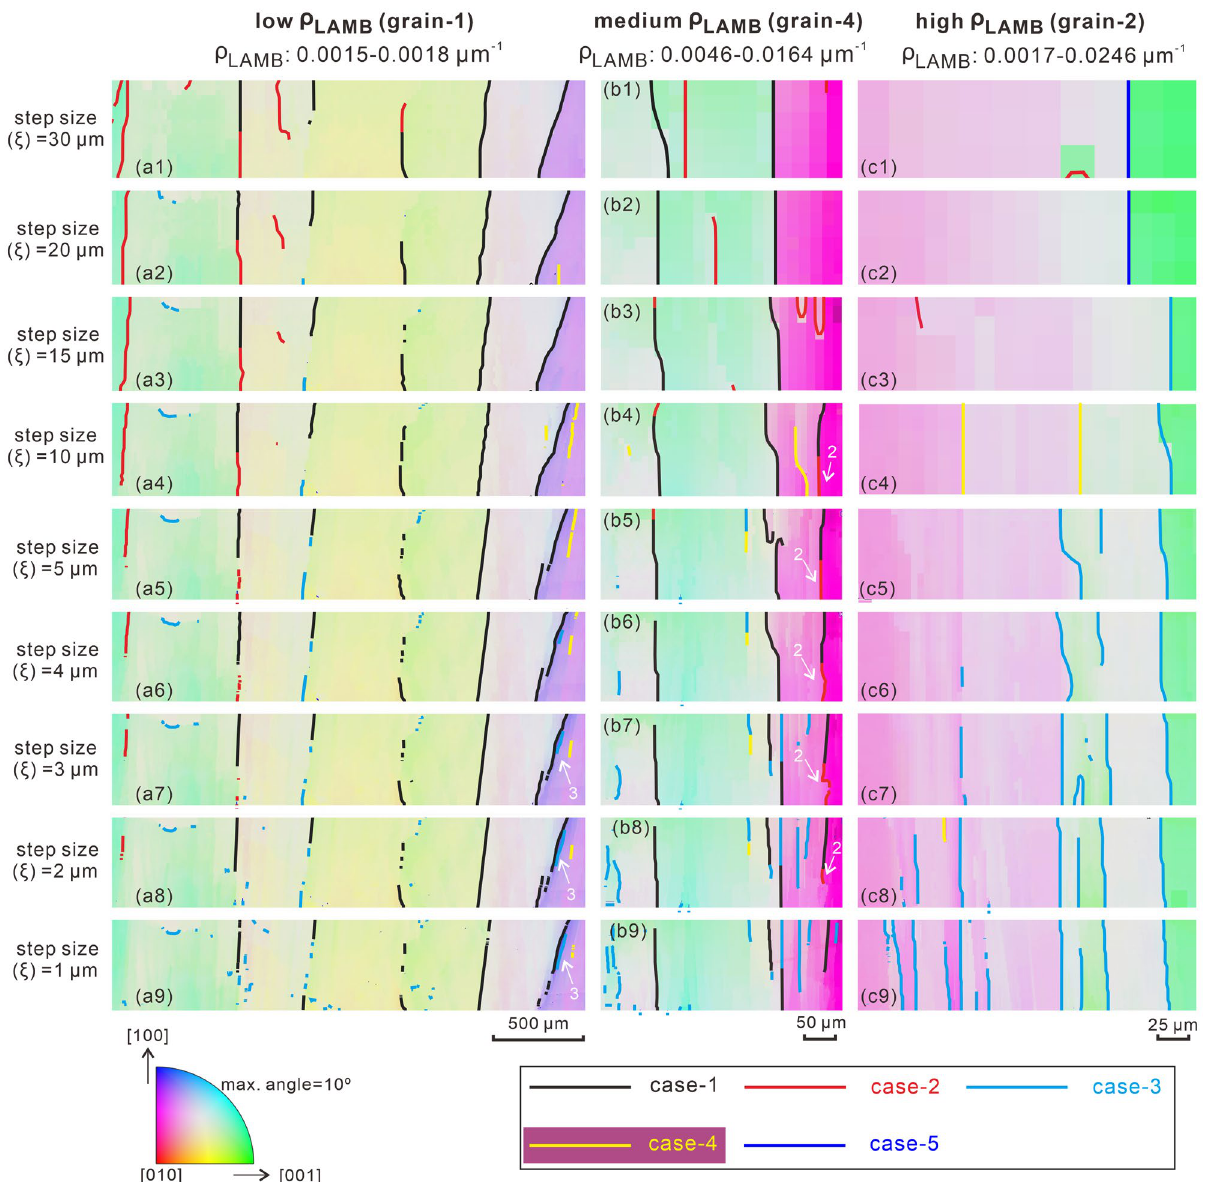
Figure 3. Five variants (case-1 to -5) of LAMB in three representative ( a1 – a9 ) low, ( b1 – b9 ) medium and ( c1 – c9 ) high LAMB density (ρ LAMB ) olivine grains. All grains are color-coded with their orientations. Cavities and cracks can cause a minor amount of spurious LAMBs (irregular dots and lines), which become more striking at smaller step sizes, due to indexing